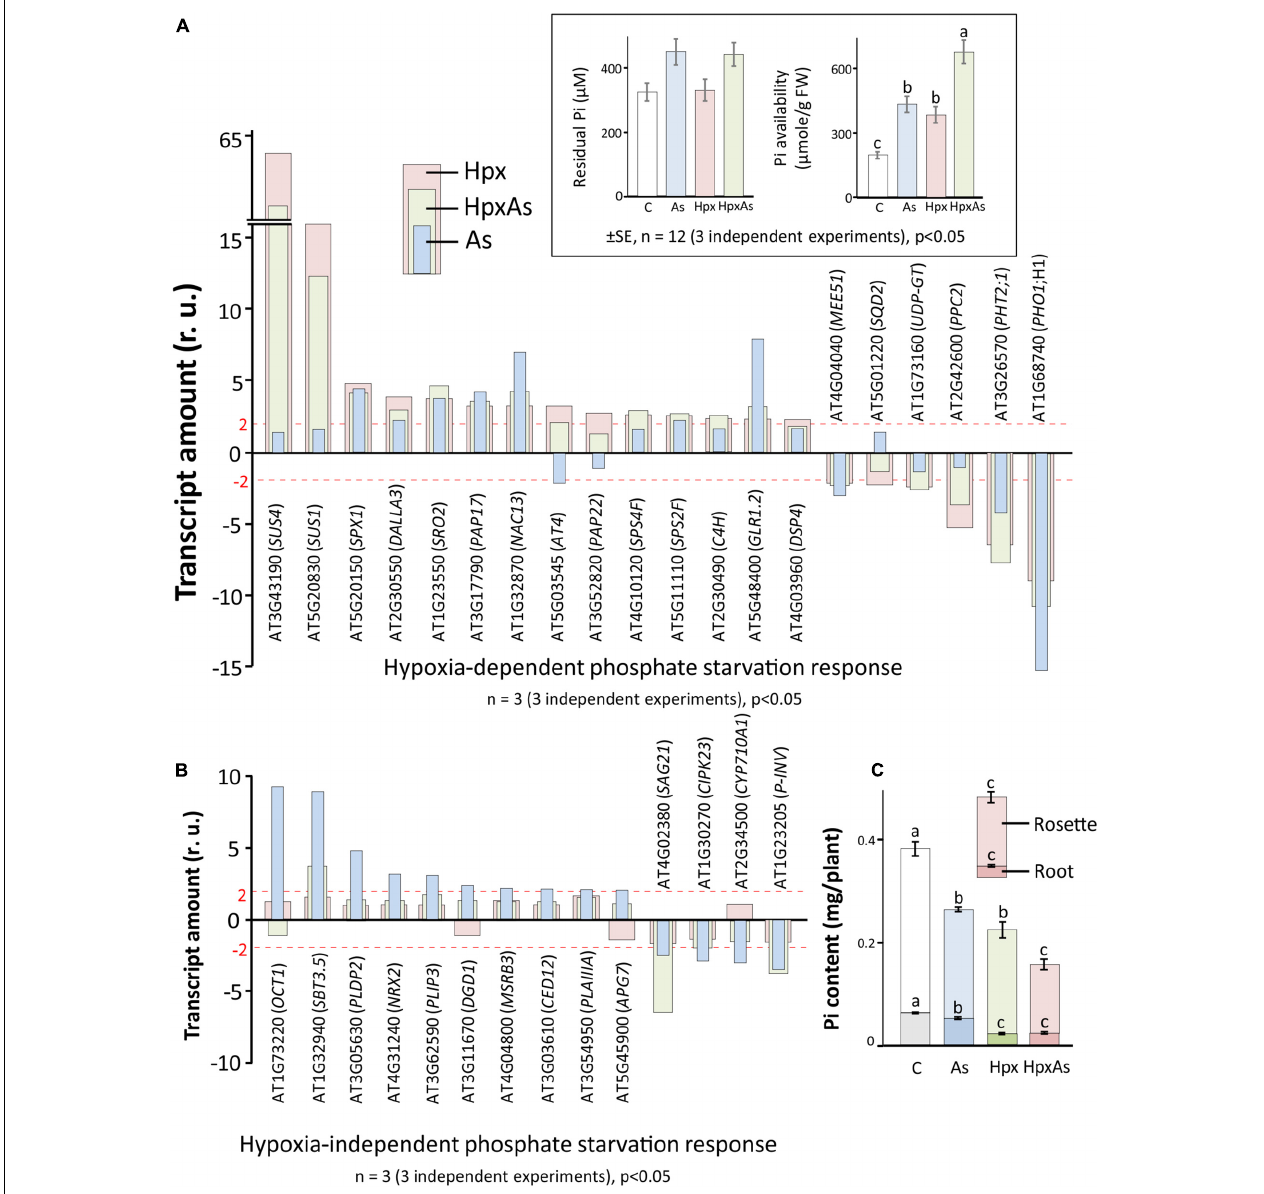
FIGURE 3 | As-, Hpx-, and HpxAs-induced phosphate starvation response in roots. Phosphate starvation-related transcripts were first screened for significant changes (–2 ≥ fc linear ≥ 2, FDR p ≤ 0.05) and subsequently for specificity of their response to hypoxia. Phosphate starvation response comprises genes not only related to uptake, transport, and assimilation of inorganic phosphate, but also those involved in galactolipid and sulfolipid biosynthesis, as well as phospholipid metabolism. The genes were categorized into those that showed (A) significant changes under Hpx-exposure and (B) no-response to Hpx, but significant response to As. The inset depicts the residual Pi in the nutrient media after 7 days of treatment given along with calculated Pi-availability per gram tissue based on the total biomass accumulated per pot at the end of treatment. The complete list with relative expression values for phosphate starvation-related genes are given in Supplementary Table 2 . In addition, heat map and a complete list of additional transcripts related to lipid signaling and phosphatidylinositol metabolism which are not part of Figures 2 , 3 are given in Supplementary Figure 1 and Supplementary Table 3 . (C) Phosphate content measured using LC-MS/MS (Kumar et al., 2019) is presented. Data is calculated per plant using accumulated dry weight under different treatments (respective Pi-content in root and rosette is also visible) (means ± SE, n = 4; 4 independent experiments; Tukey’s test, p <